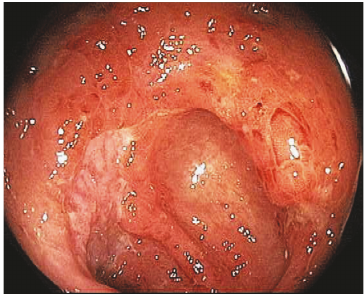
Figure 43: Endoscopic image of the ileocecum involved by B-cell lymphoma.